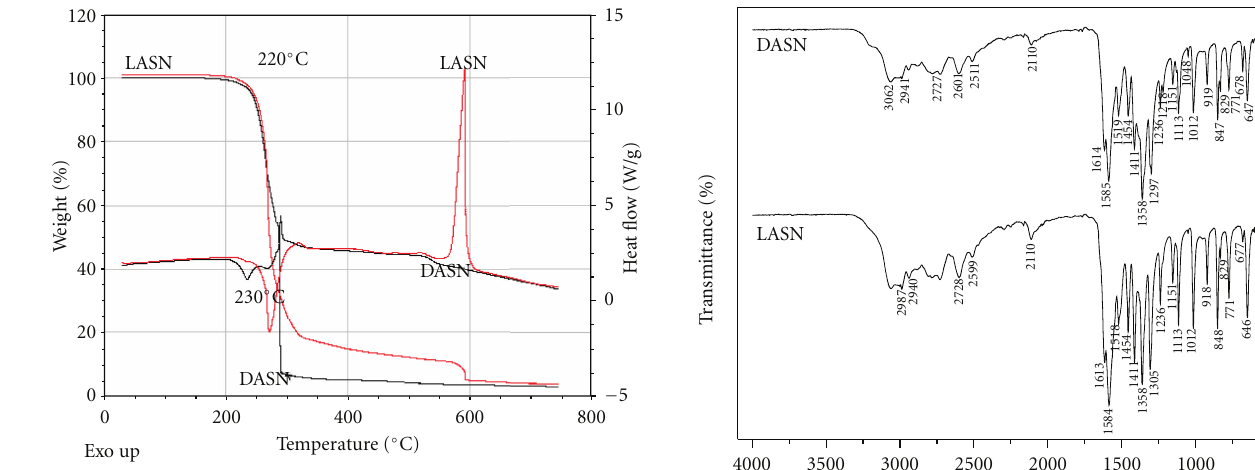
Figure 2: TGA and DSC curves of LASN and DASN.